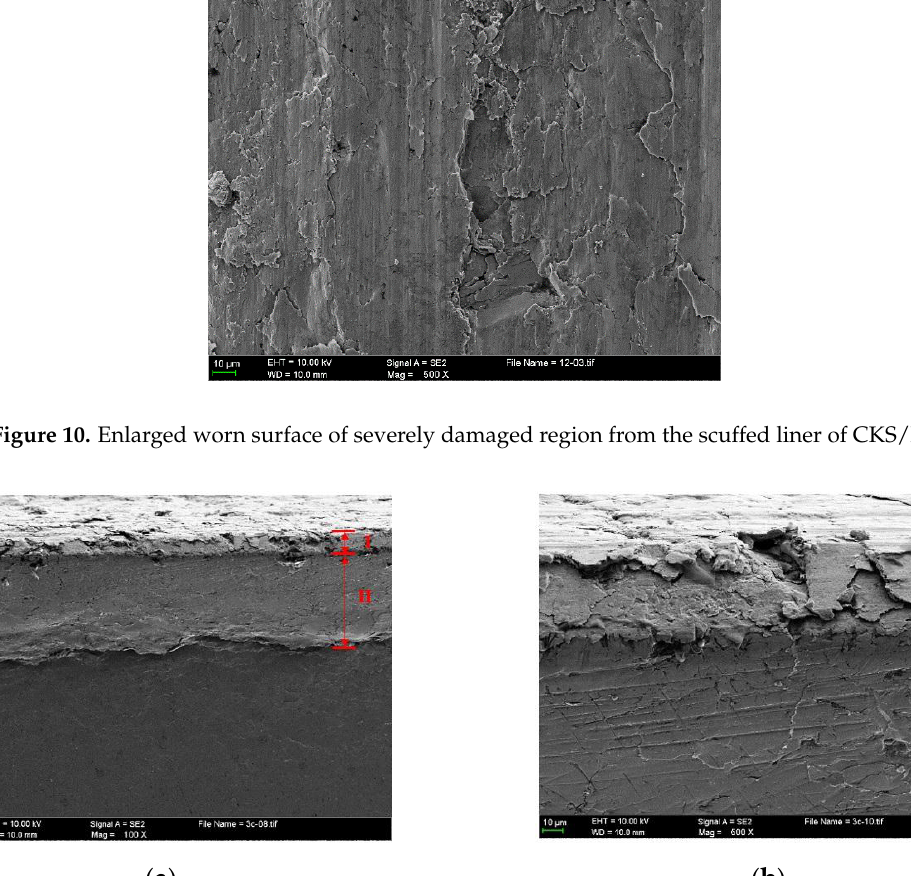
( c ) Figure 9. Scuffed cylinder liner surface and elemental content of CKS/Fe. ( a ) SEM image; ( b ) EDS spectrum e; ( c ) EDS spectrum f